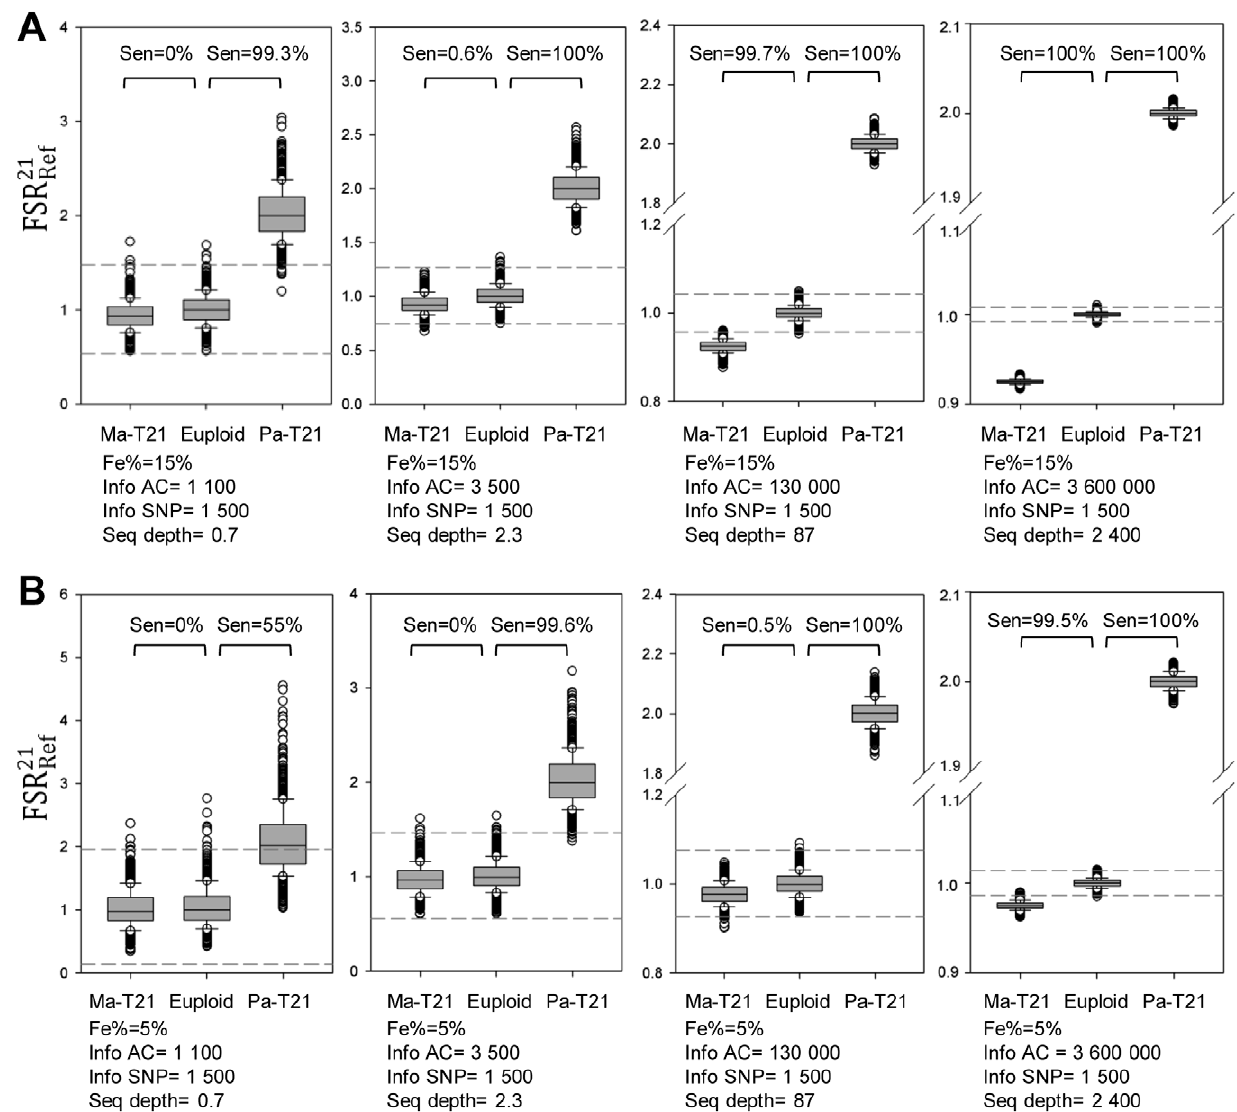
Figure 3. Computer simulation for T21 detection for fractional fetal DNA concentrations of 5% and 15%. In order to obtain a specificity of greater than 99%, the cutoffs for T21 differentiation were chosen at 3 standard deviations above and below the mean F-S ratio of the euploid group. The sensitivity for paternally- and maternally-derived T21 detection was investigated on different numbers of informative allelic counts on chr21 and chrRef, respectively, for a fractional fetal DNA concentration of 15% (A). Similar analysis was performed for a fractional fetal DNA concentration of 5% (B). (Ma-T21: maternally-derived T21. Pa-T21: paternally-derived T21. Sen=sensitivity. Fe%=fractional fetal DNA concentration. Info AC=informative allelic counts on each of chr21 and chrRef. Info SNP=informative SNPs on each of chr21 and chrRef. Seq depth=sequencing depth. Info AC=Info SNP 6 Seq depth).